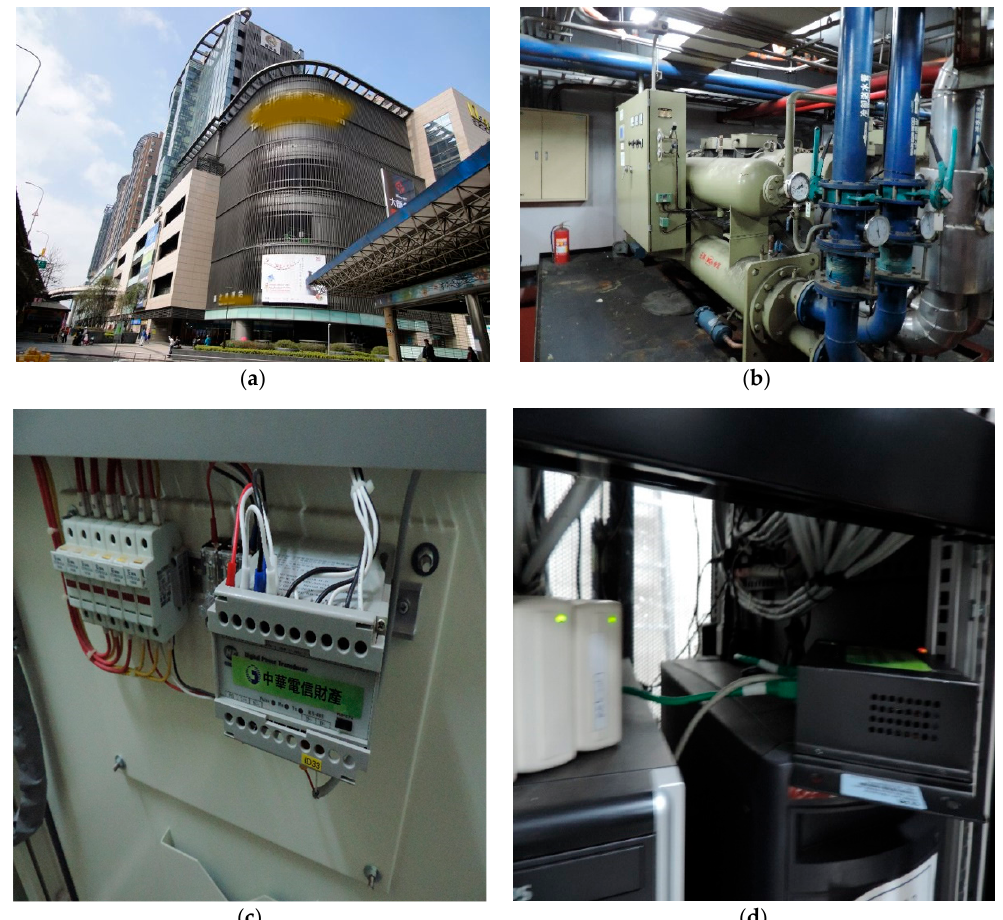
Figure 1. A real test site for presenting artificial intelligence (AI)-assisted heating ventilation and air conditioning (HVAC) control performances. ( a ) The case study facility; ( b ) the chiller system including 6 chillers installed in the building; ( c ) a power meter for measuring the energy consumption; ( d ) a networked temperature/humidity sensor module for detecting the necessary parameters for the HVAC control.